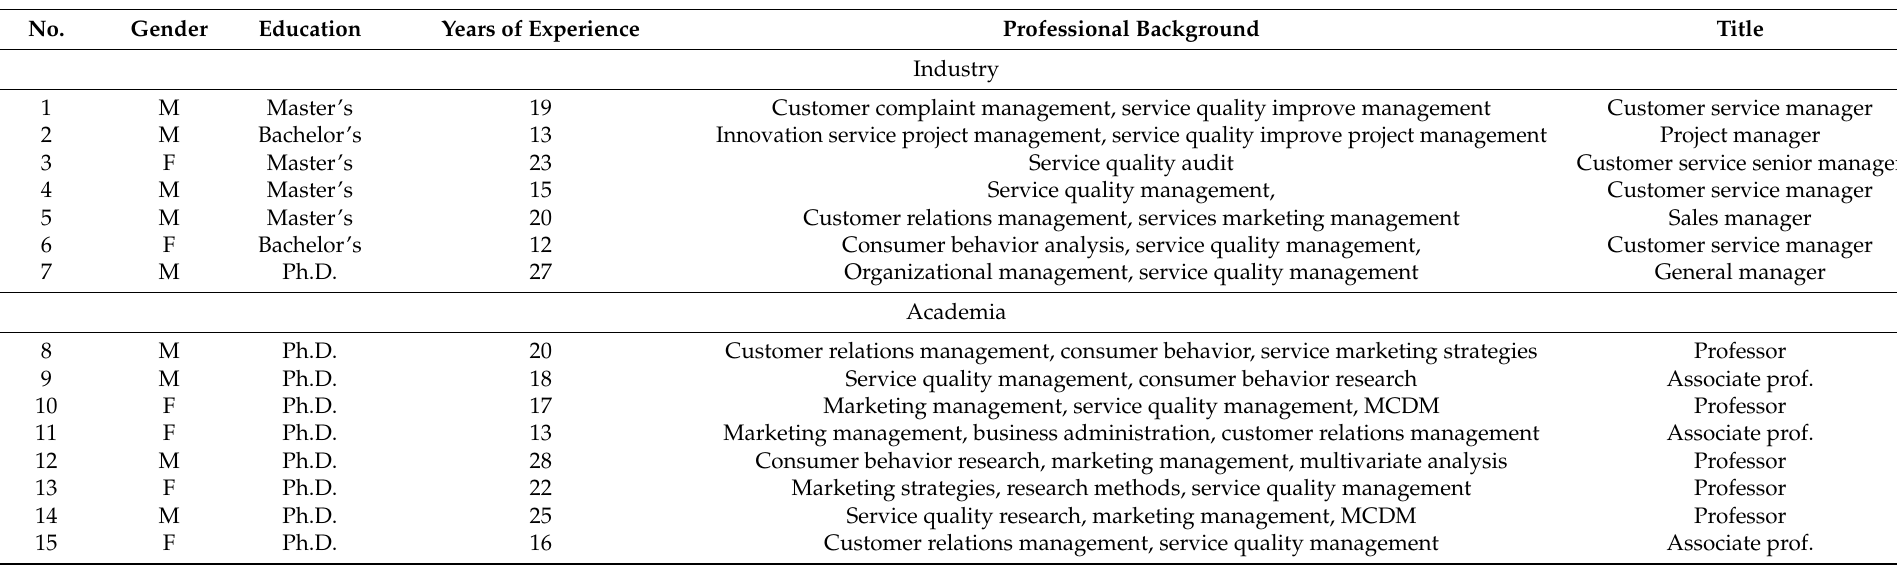
Table A1. Experts’ background